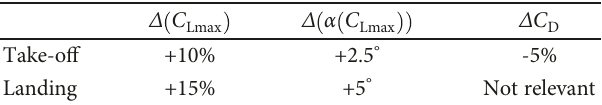
Figure 33: E ff ect of a droop nose on stall process for landing con fi guration: computed friction lines. Table 8: Aerodynamic performance improvements due to the morphing droop nose